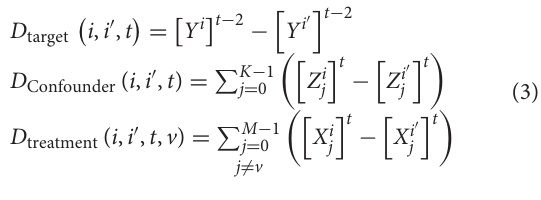
where u ∗ is the optimal assignment, n c is the number of control samples and n t is the number of treatment samples. In this formulation, u ii ′ = 1 indicates that sample i of treatment set and sample i ′ of control set are paired, and u ii ′ = 0 indicates otherwise. D ( i , i ′ , t ) is the matching distance between